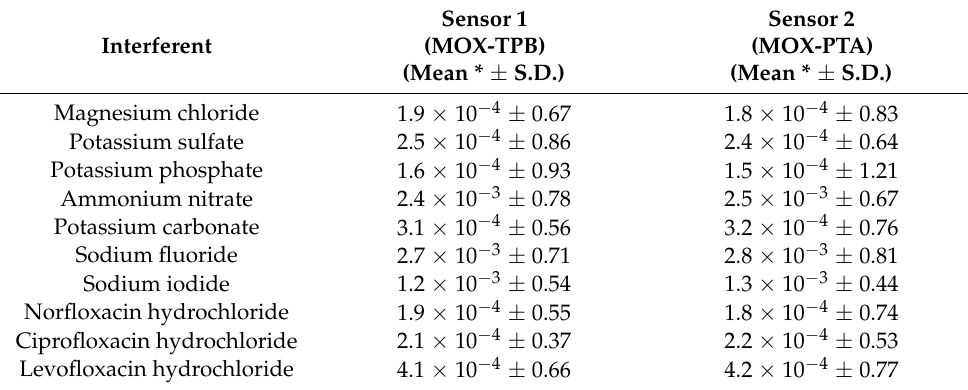
Table 3. Potentiometric selectivity coefficients of the proposed MOX selective sensors by the matched potential method.